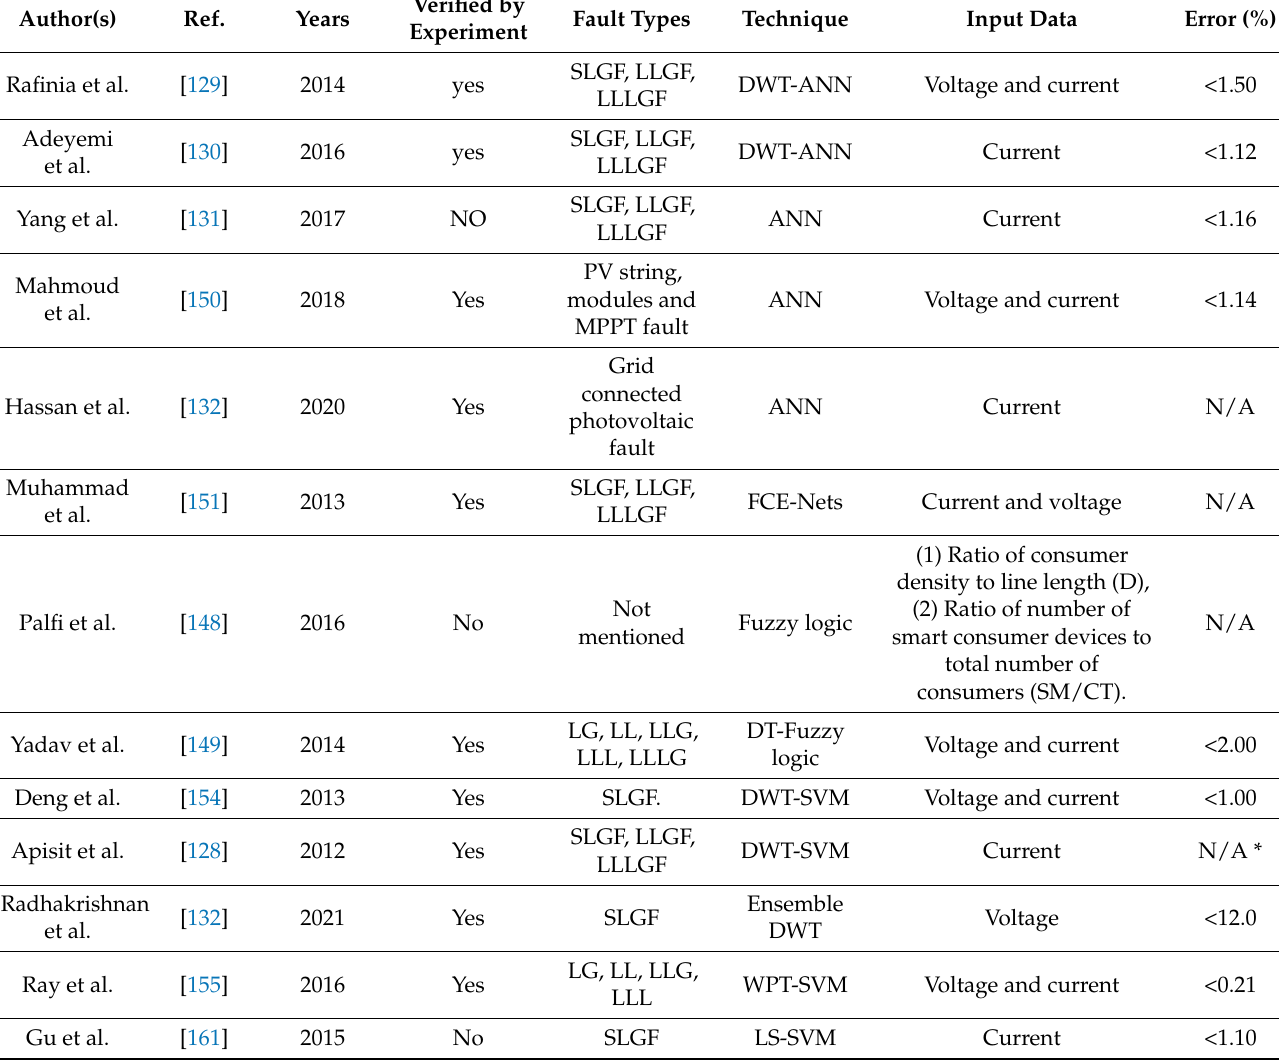
Table 6. Summary of methods to identify the source of